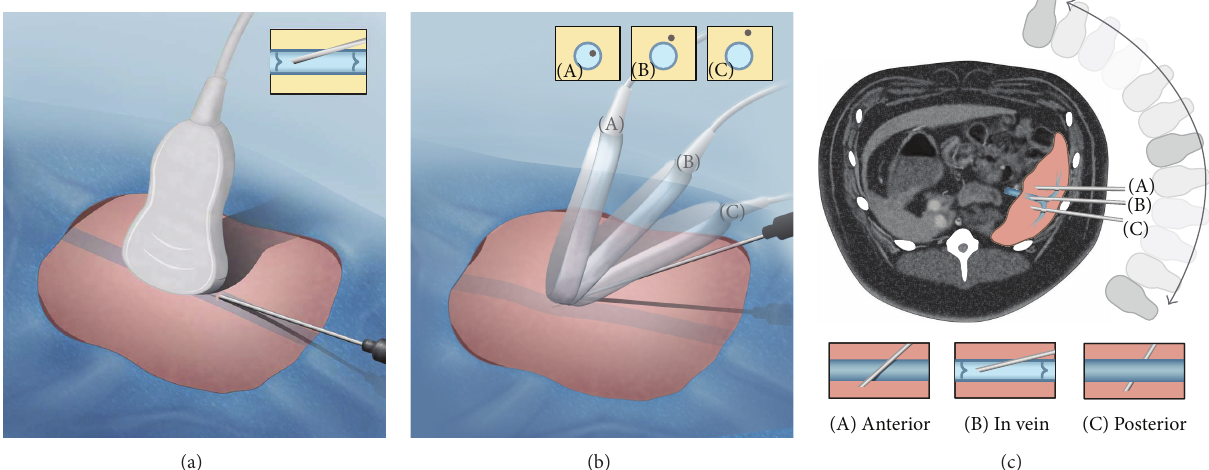
Figure 2: Illustration of ultrasound guided venous access. (a) Illustration demonstrating the in-plane technique for the ultrasound guided access. The inset shows a schematic of the needle within the vein in long axis. (b) Illustration demonstrating out-of-plane technique for ultrasound guided access. The inset shows a schematic of the blood vessel in cross section with the dot being the needle position in the respective transducer locations. (c) Overlay illustration on an axial CT image demonstrating the relationship of the needle to the venous structure, with different positions of the fluoroscope C arm. The pink shading over the CT image denotes the spleen.